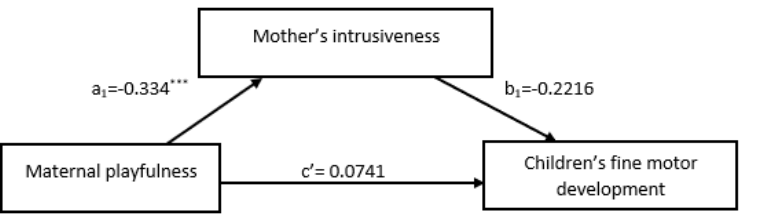
Figure 3. Effect of maternal playfulness on children’s gross motor development mediated by mothers’ intrusiveness. Asterisks (***) indicate the significance effect of maternal playfulness on mother’s intrusiveness ( p < 0.001) (a1).